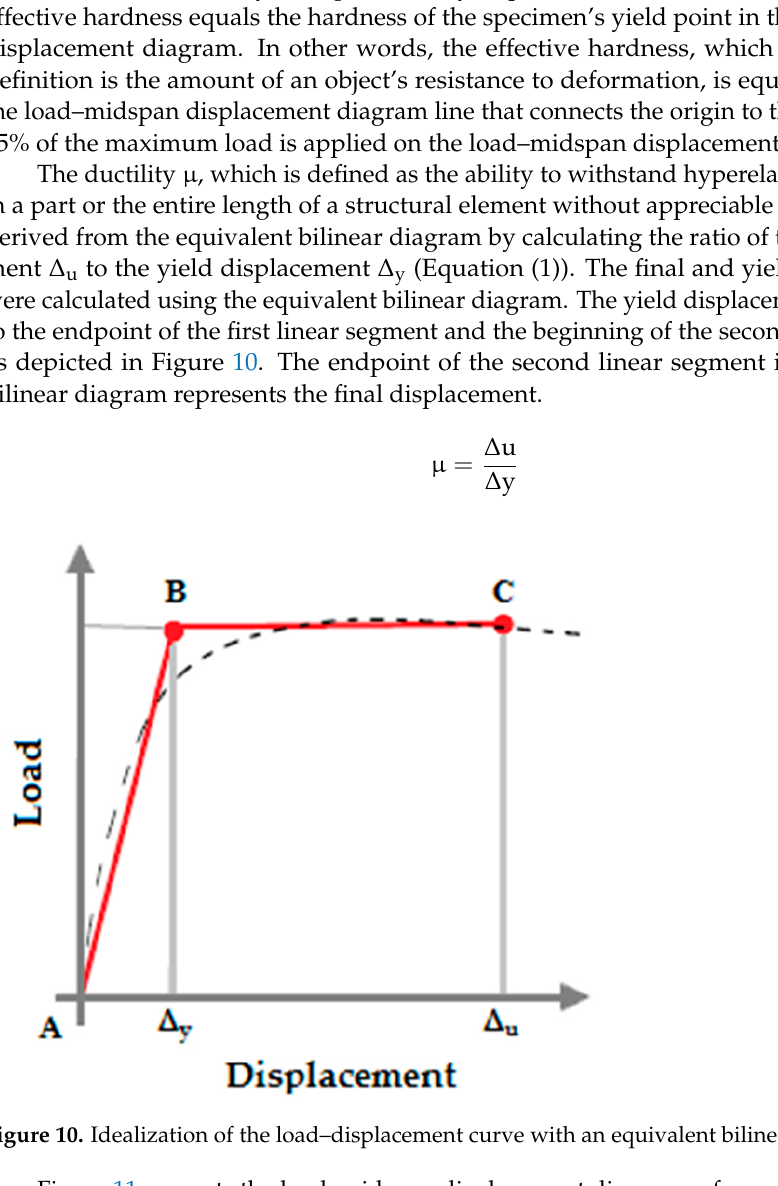
( d ) Figure 11. Load–midspan displacement diagrams: ( a ) Group A specimens, ( b ) Group B specimens, ( c ) Group C specimens, and ( d ) Group D specimens. 0204060 80 100 120